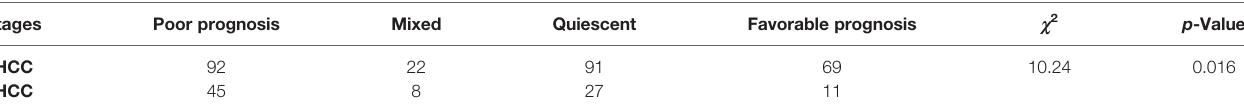
TABLE 1 | The clusters de fi ned phenotype in HCC strati fi cation. Stages Poor prognosis Mixed Quiescent Favorable